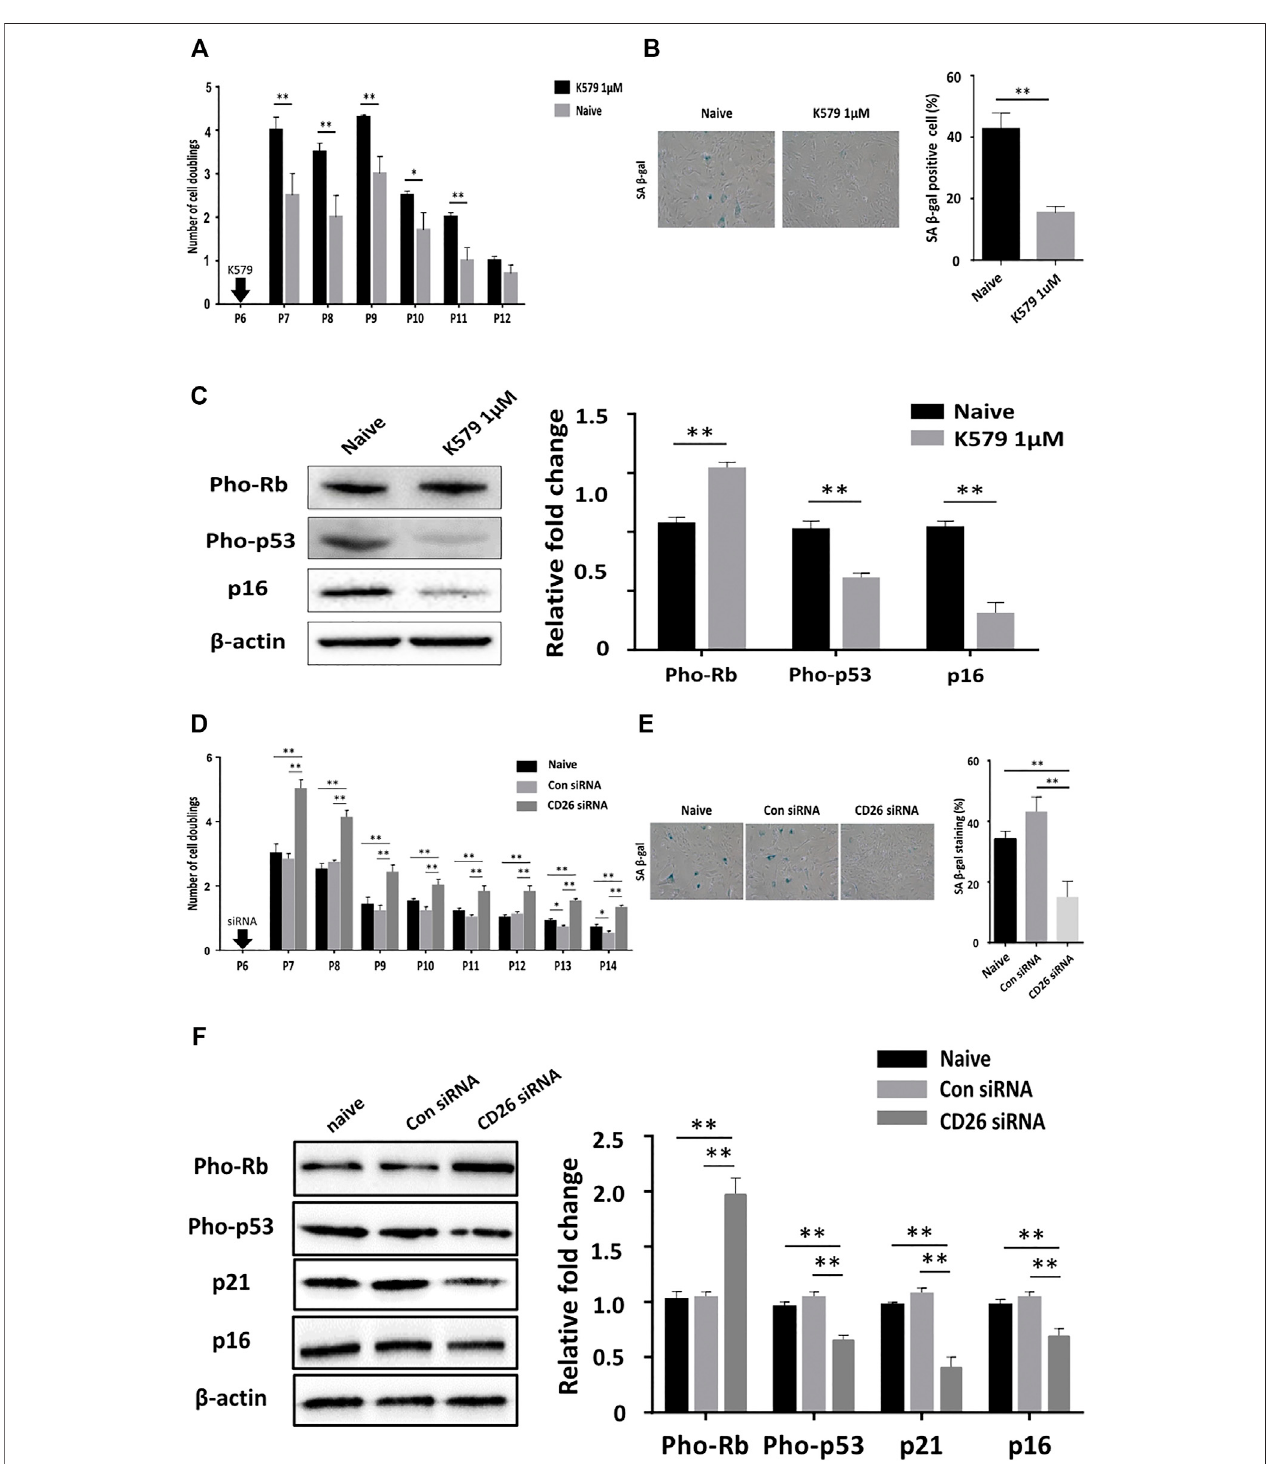
FIGURE 2 | Pharmacologic inhibition of CD26 attenuates cellular senescence of hUCB-MSCs. (A) Number of cell doublings of hUCB-MSCs after K579 treatment ( n (cid:1) 3). (B) RepresentativeImages (left) andbargraph (right) ofSA β -galstainednaïveandK579-treatedcells( n (cid:1) 4,passage10);Scalebar,50 μ m. (C) Immunoblotting images (left) and densitometry (right) of senescence-associated proteins in naïve and K579-treated cells ( n (cid:1) 3). (D) Number of cell doublings of hUCB-MSCs after transfectionwithscrambledcontrolorCD26siRNA( n (cid:1) 3). (E) Representativeimages (left) andbargraph (right) ofSA β -gal-stainedcellsofscrambledcontrol-or CD26 siRNA- transfected hUCB-MSCs ( n (cid:1) 3, passage 10); Scale bar, 50 μ m. (F) Immunoblotting images (left) and densitometry (right) of senescence-associated proteins in scrambled control- or CD26 siRNA-transfected hUCB-MSCs ( n (cid:1) 3, passage 6). All microscopic images were taken with 100X original magni fi cation. Abbreviation:hUCB-MSCs,humanumbilicalcord bloodmesenchymalstemcells; siRNA, smallinterferingRNA;SA β -gal, senescence-associated β galactosidase.* p < 0.05; ** p < 0.01.